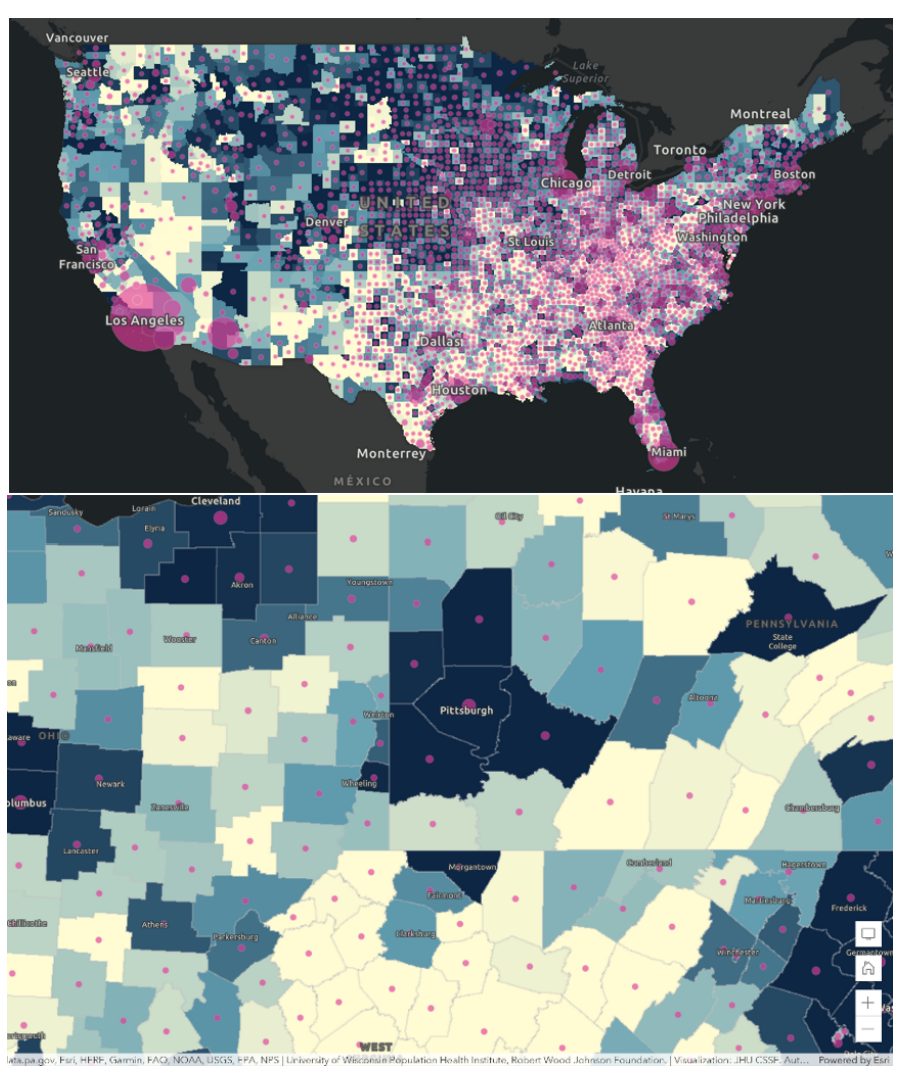
Figure 9. COVID-19 Counts on 14 May 2022 versus at least some college education LINK: https: //www.arcgis.com/home/item.html?id=e1481c5a5a314a60951f2a3c387eed15 (created on 15 June 2022). ( Top ) Distribution of COVID-19 cases versus education on the national level. ( Bottom ) Distribution of COVID-19 versus education on local levels with urban areas like Pittsburgh, PA and Columbus, OH having corresponding lower education attainment and higher counts of COVID-19 cases. Larger circles correspond to higher counts of the